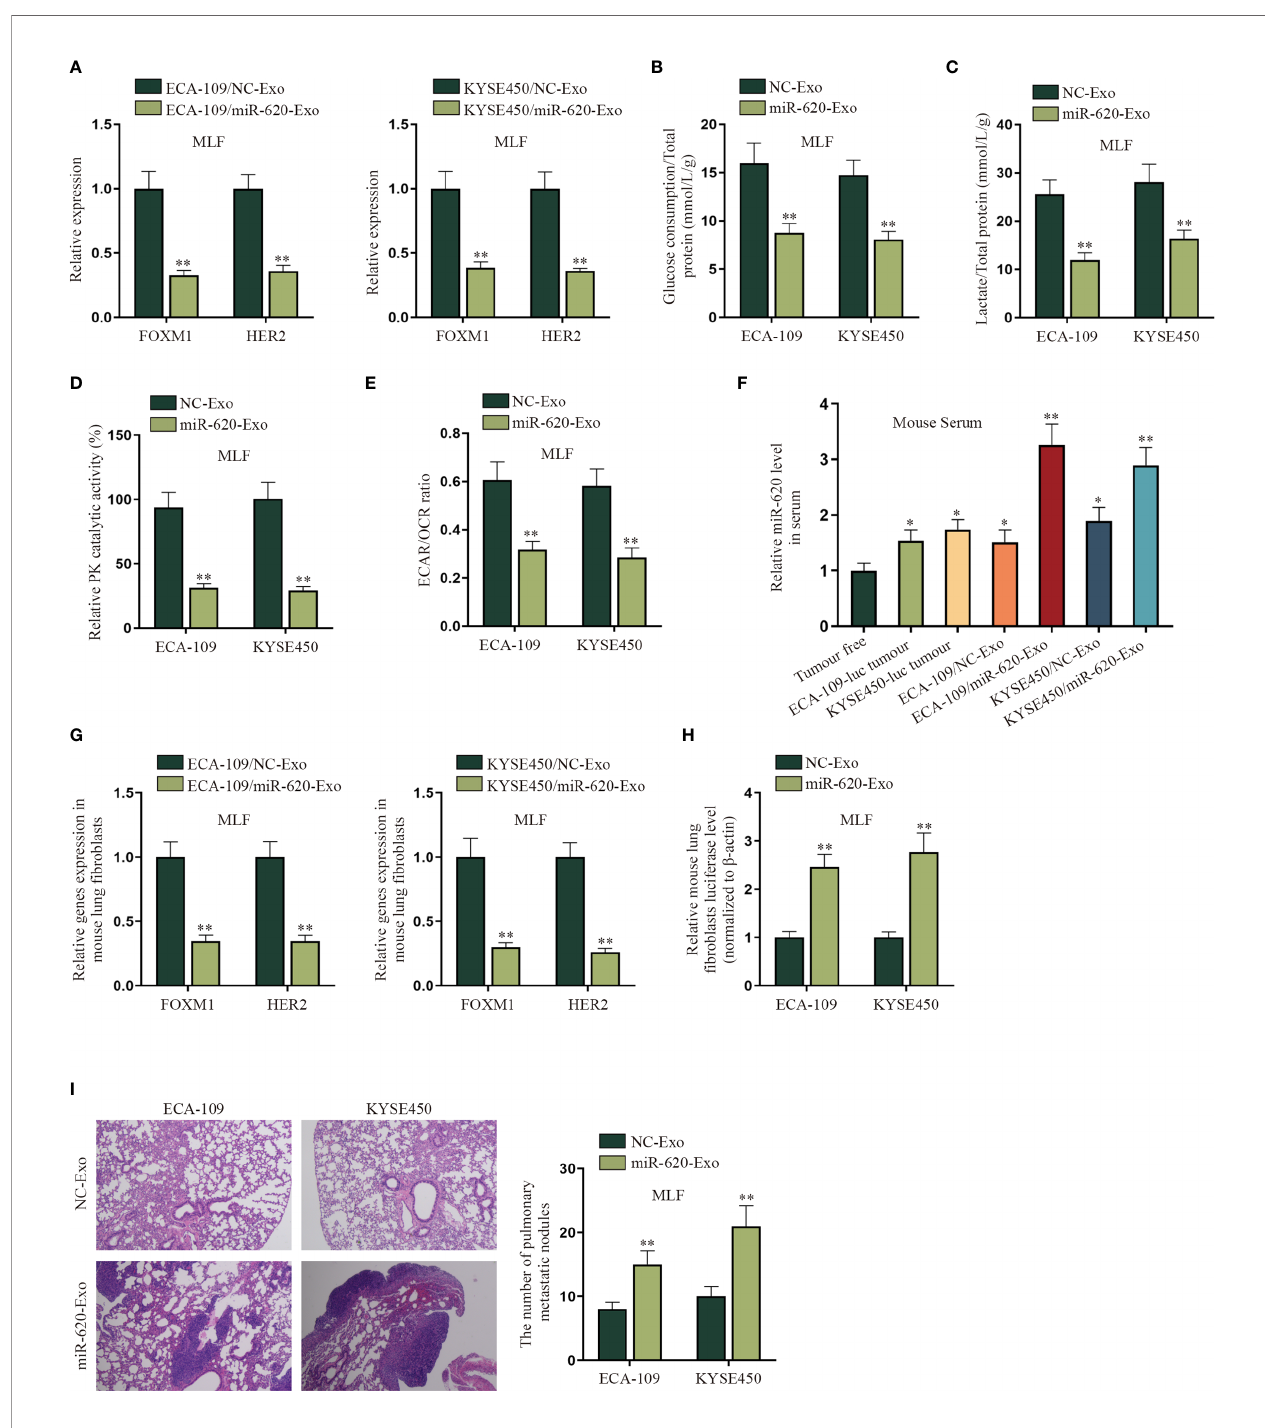
FIGURE 7 | Exosomal miR-620 inhibits the aerobic glycolysis of lung fi broblasts and promotes ESCC metastasis. (A) The expression of FOXM1 and HER2 in MLF cells accepting different cancer-secreted exosomal miR-620 was detected by qRT-PCR. (B – E) qRT-PCR was utilized to detect the glucose consumption, total lactate protein, relative PK catalytic activity, and the ECAR/OCR ratio in MLF accepting different cancer-secreted exosomal miR-620. (F) Luciferase-labeled ESCC cells (ECA-109-luc and KYSE450-luc) were constructed, and qRT-PCR was used to assess the expression level of miR-620 in mouse serum in ESCC cells accepting exosomal miR-620 (ECA- 109/miR-620-Exo and KYSE450/miR-620-Exo) in comparison with tumor-transplanted groups (ECA-109-luc tumor and KYSE450-luc tumor). (G) qRT-PCR was used to detect the expression of FOXM1 and HER2 in MLF treated with ECA-109/miR-620-Exo and KYSE450/miR-620-Exo. (H) qRT-PCR was used to detect the relative MLF luciferase level in mice treated with miR-620-Exo. (I) The metastasis of mice was observed through HE staining, and the number of pulmonary metastatic nodules was measured in different groups. * p < 0.05, ** p <